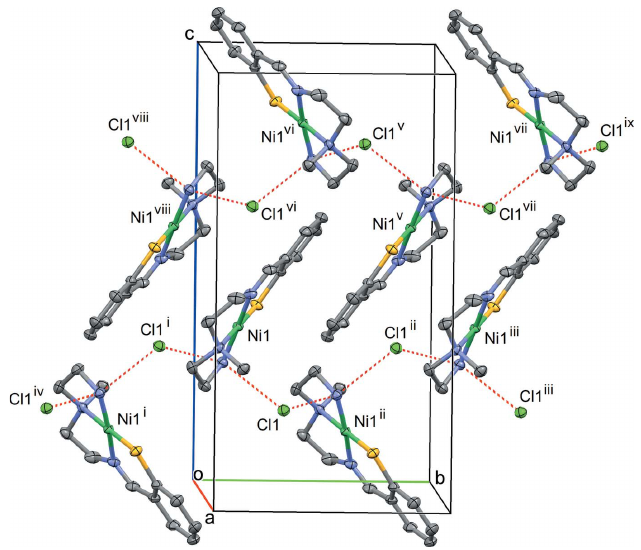
Figure 3 Hydrogen-bond network of 1 . Hydrogen atoms are omitted for clarity. Hydrogen bonds are shown as red dashed lines. [Symmetry codes: (i) (cid:5) x + 1 , y (cid:5) 1 , (cid:5) z + 1 ; (ii) (cid:5) x + 1 , y + 1 , (cid:5) z + 1 ; (iii) x , y + 1, z ; (iv) x , y (cid:5) 1, z ; 2 2 2 2 2 2 Figure 4 (v) (cid:5) x + 1, (cid:5) y + 1, (cid:5) z + 1; (vi) x + 1 , (cid:5) y + 1 , z + 1 ; (vii) x + 1 , (cid:5) y + 3 , z + 1 ; 2 2 2 2 2 2 1 H NMR spectra of ( a ) 1 (400 MHz) and ( b ) 2 (300 MHz) in CD (viii) (cid:5) x + 1, (cid:5) y , (cid:5) z + 1; (ix) (cid:5) x + 1, (cid:5) y + 2, (cid:5) z + 1.]